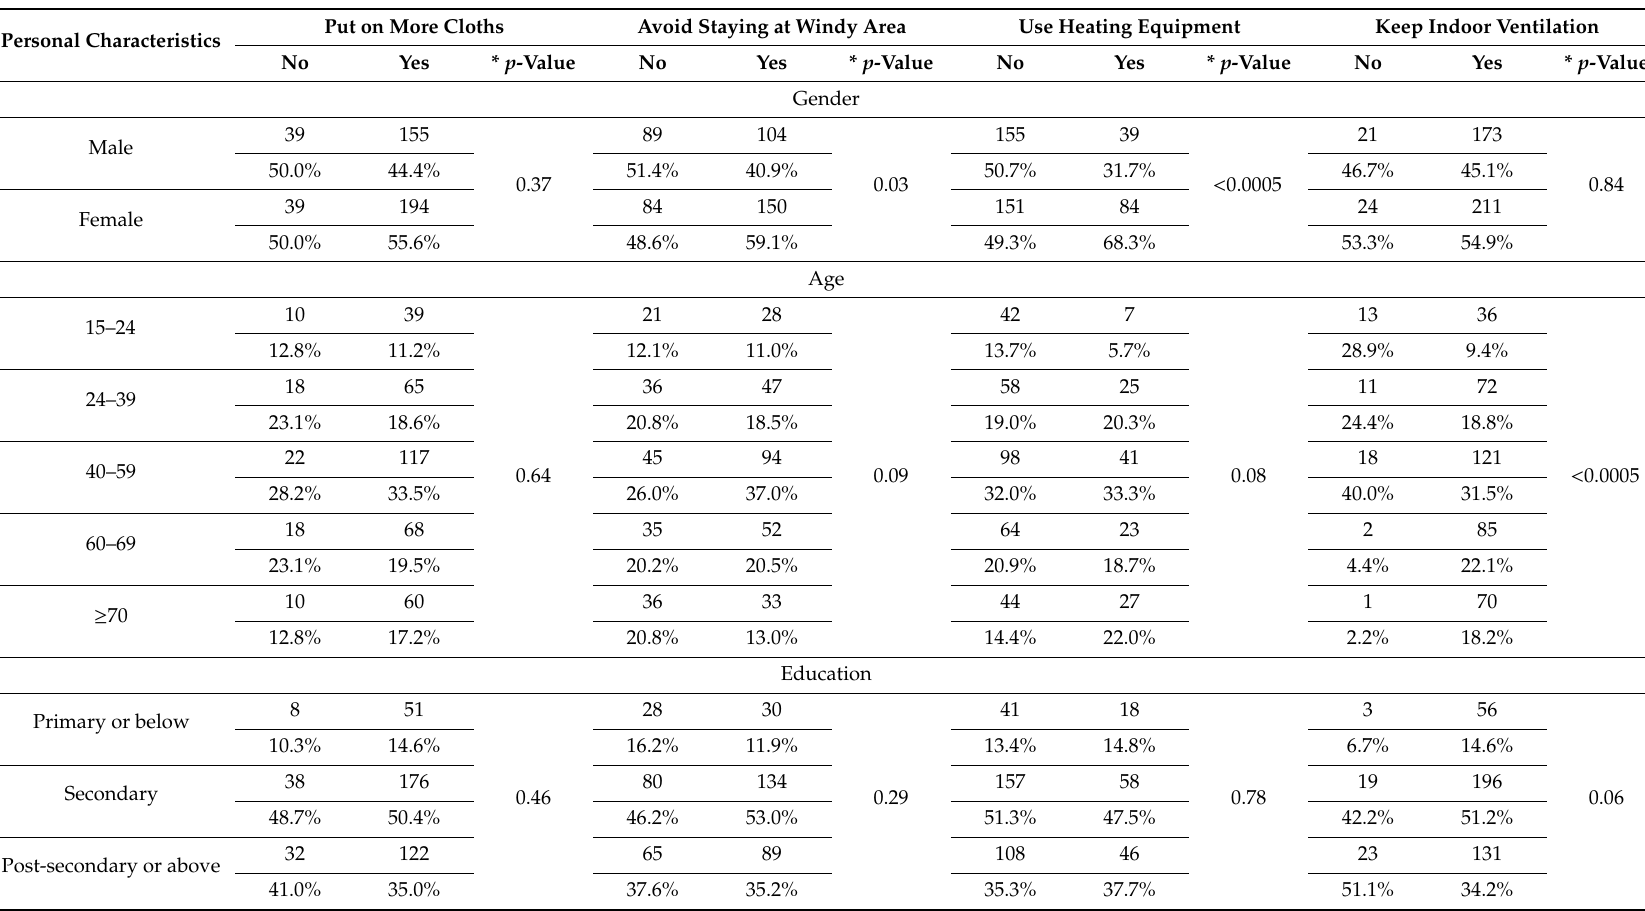
Table 3. Association between personal characteristics and uptake of personal cold protection behaviour in 2017 cold wave using Chi-square test. Personal